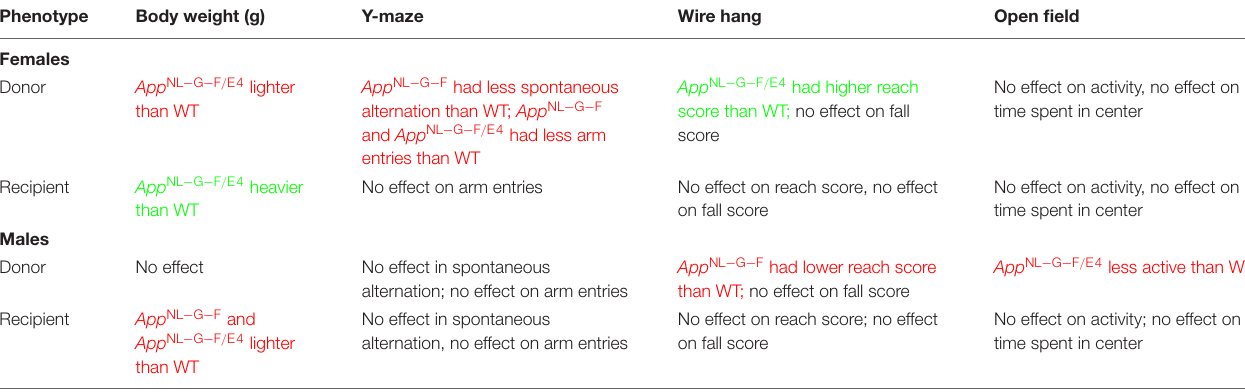
TABLE 1 | A summary table indicating the main effects on body weights and behavioral performance in donor and recipient mice, separated by sex 1